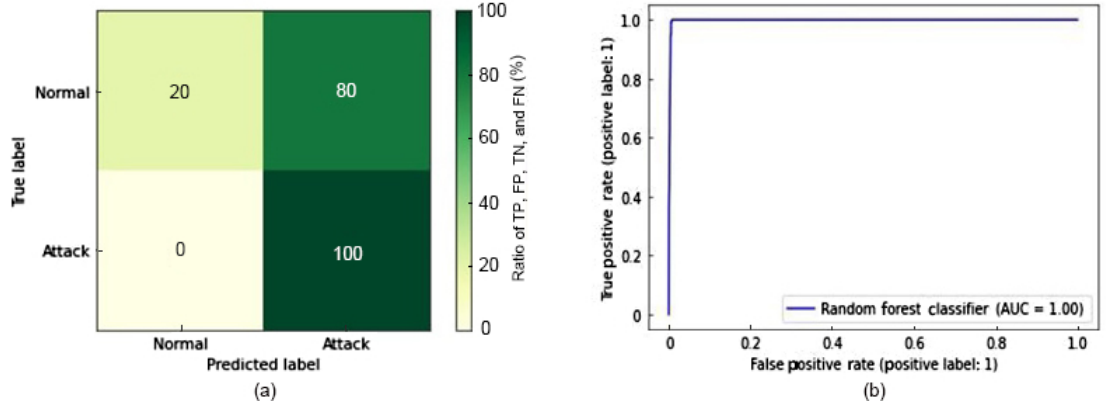
Fig. 7 Confusion matrix and ROC curve of RF-PCC on the Bot-IoT dataset.